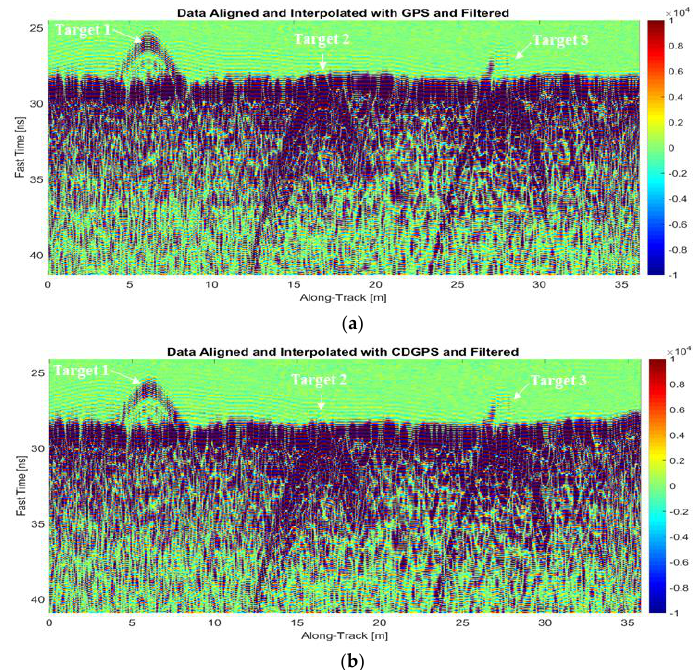
Figure 9. Processed radargram Test 1-Track 1: ( a ) aligned ad interpolated radargram by exploiting GPS information and after filtering operations; ( b ) aligned and interpolated radargram by exploiting CDGPS information and after filtering operations.